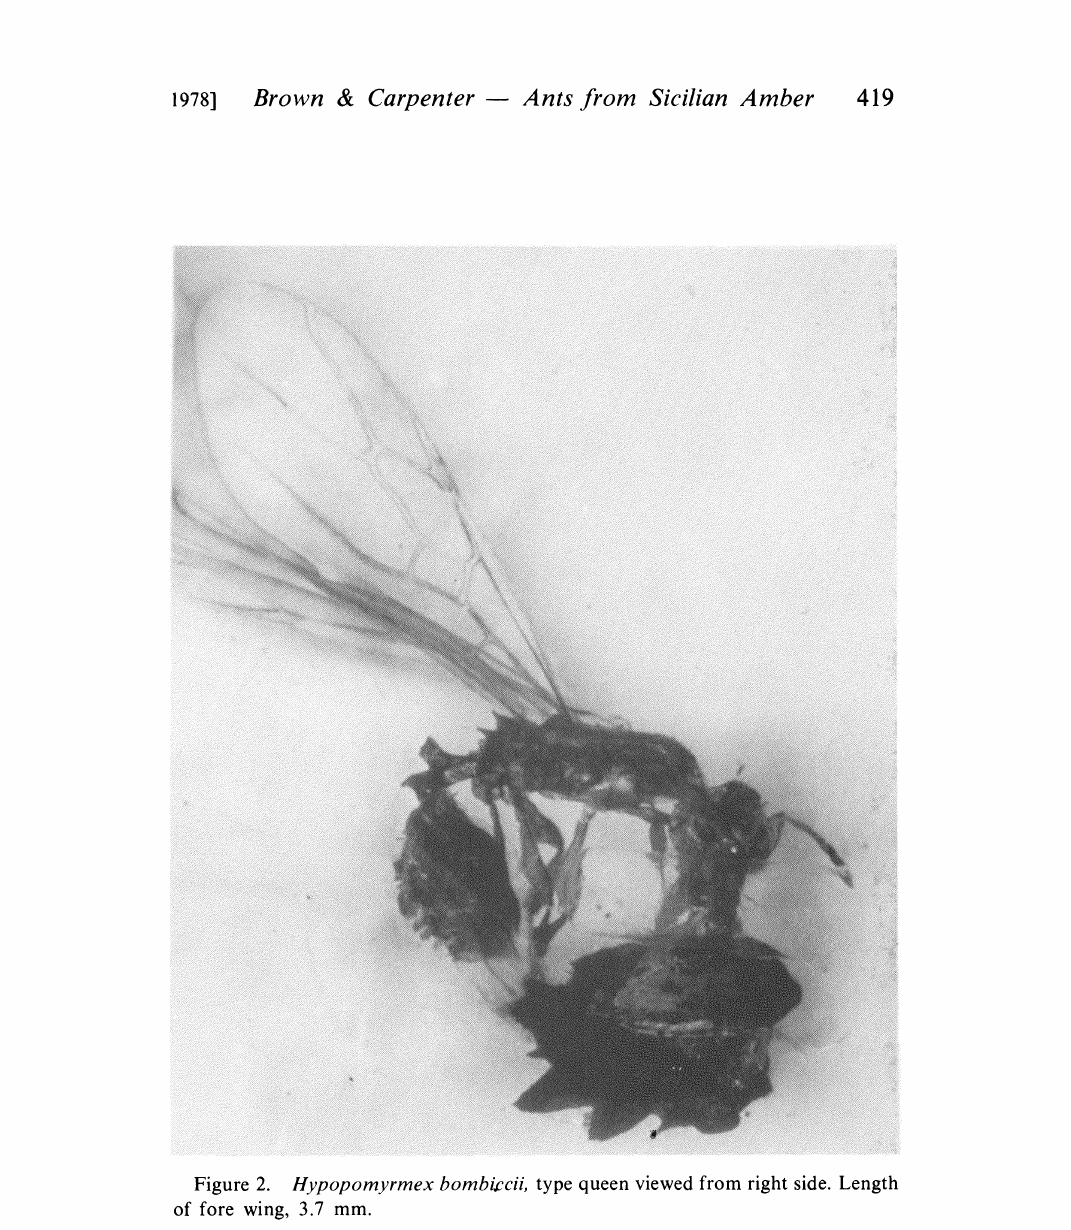
Figure 2. Hypopomyrmex bombigcii, type queen viewed from right side. Length of fore wing, 3.7